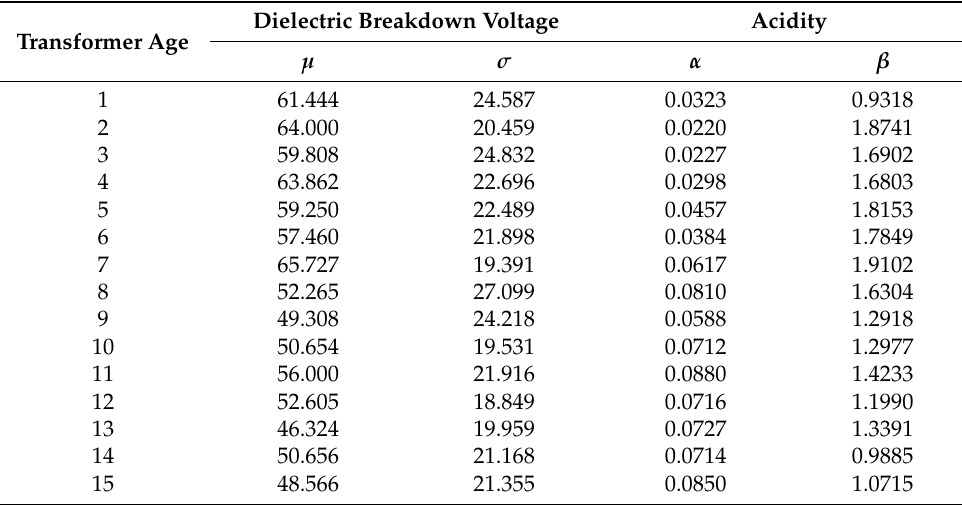
Table 2. Computed distribution parameters for dielectric breakdown voltage and acidity.